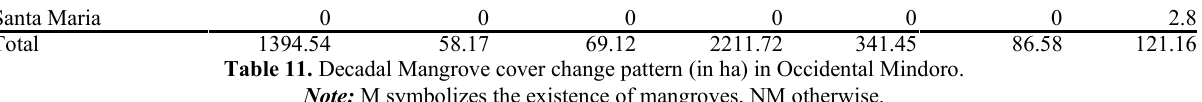
Table 11. Decadal Mangrove cover change pattern (in ha) in Occidental Mindoro. Note: M symbolizes the existence of mangroves, NM otherwise.